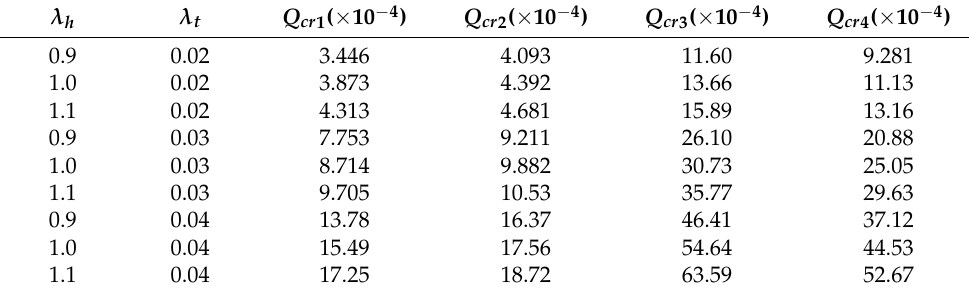
Table 6. Four critical loads under different λ h and λ t ( β = ± 0.2 ).